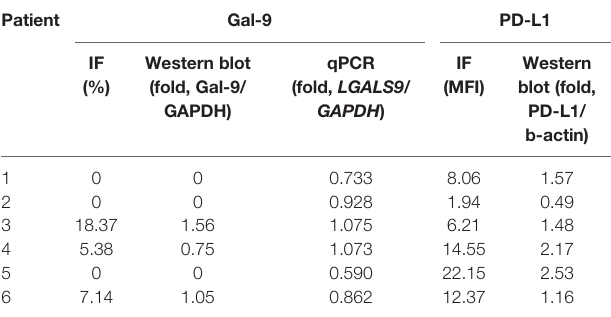
TABLE 1 | Detection of Gal-9 and PD-L1 expression using different methods. Patient Gal-9 PD-L1